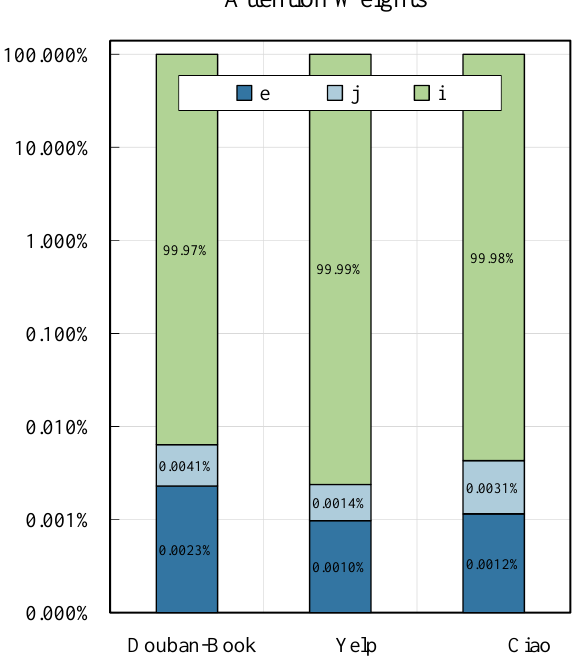
Figure 6. Attention weights for each graph with different datasets.